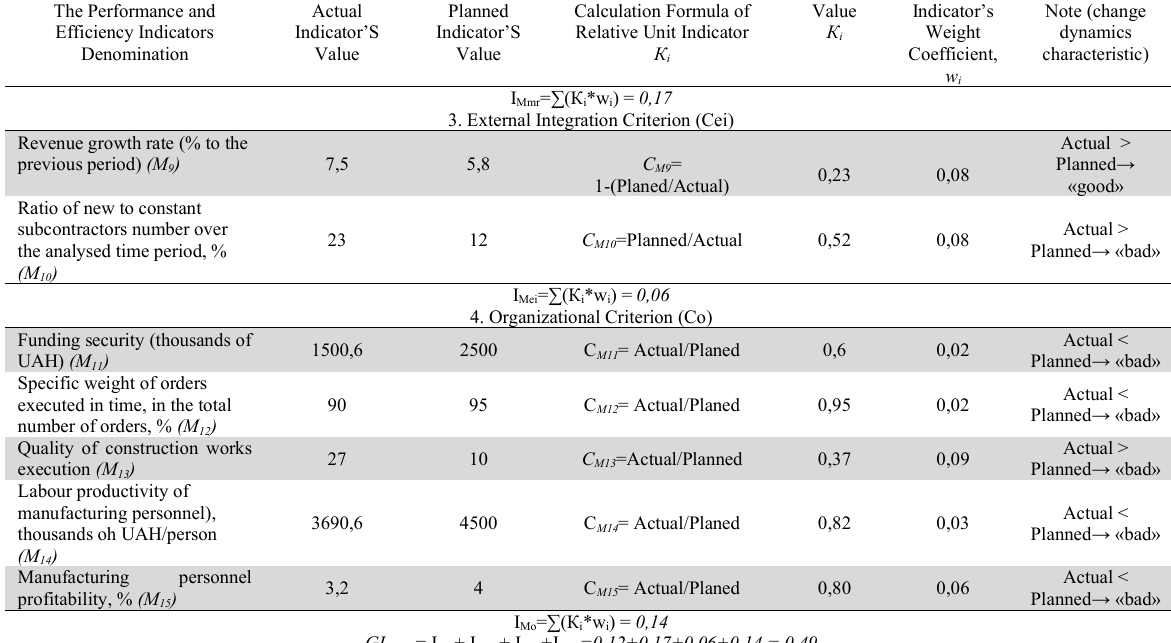
Determination of performance and efficiency indicators of manufacturing business-processes execution of a building company (M) (Cont.) The Performance and Efficiency Indicators Denomination characteristic)